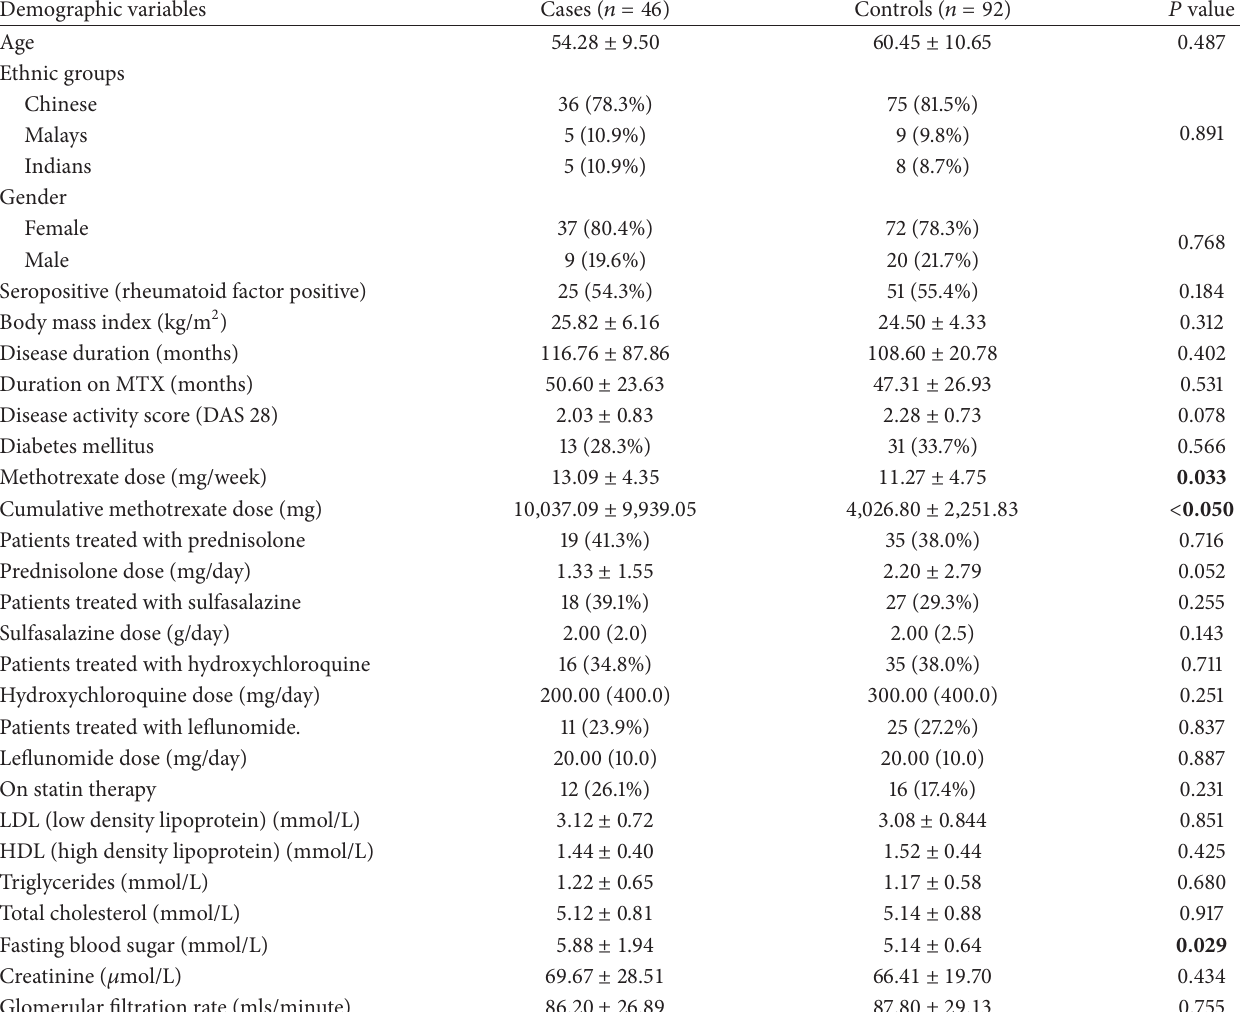
Table 1: Comparison of characteristics between cases and controls.